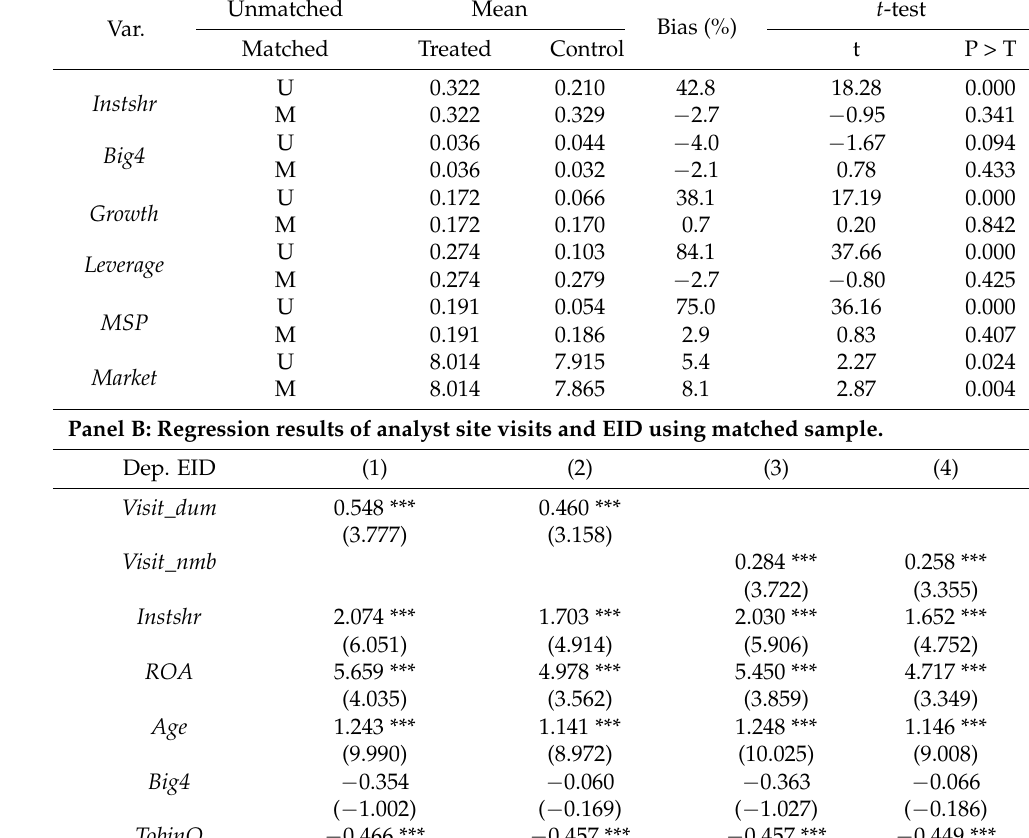
Table 8. Propensity score matching test results. Panel A: Propensity score matching balance test results.